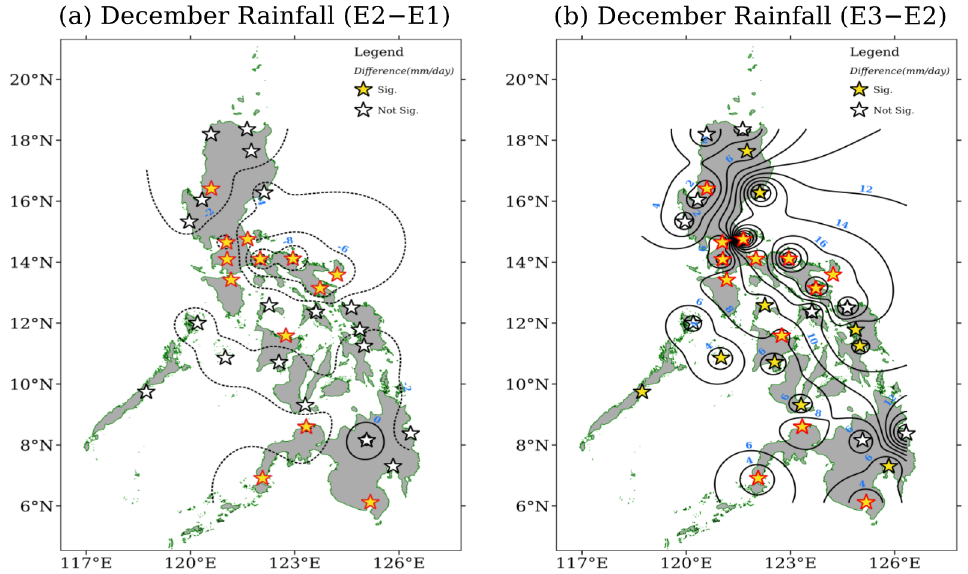
Figure 4. Differences in interpolated rainfall (contours) during December between: ( a ) E1 (1961–1976) and E2 (1977–1992) (E2 minus E1); and ( b ) E2 and E3 (1993–2008) (E3 minus E2) across the 32 PAGASA stations (stars). Negative (positive) contours are indicated by dashed (solid) lines. The contour interval is 2 mm day − 1 . Yellow shaded stars indicate a significant difference above the 90% confidence level by bootstrapping. The stars with red outlines indicate the 13 stations with significant difference in both ( a , b ).